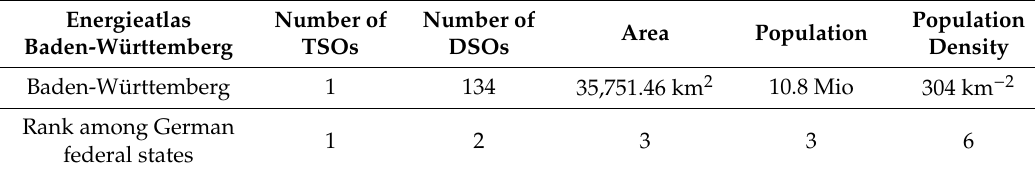
Table 2. Selected statistical numbers of Baden-Württemberg